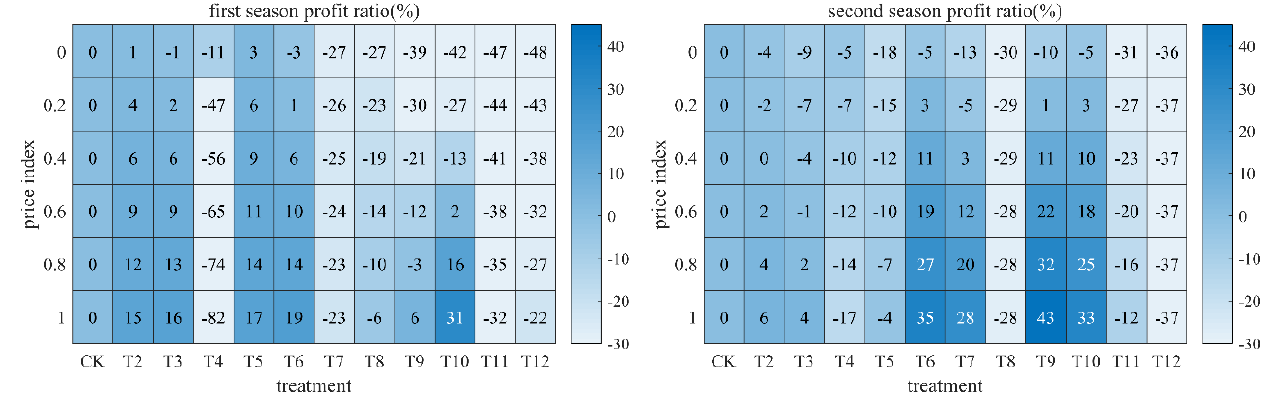
Figure 4. The tomato profit ratio in the first and second seasons of 2019.